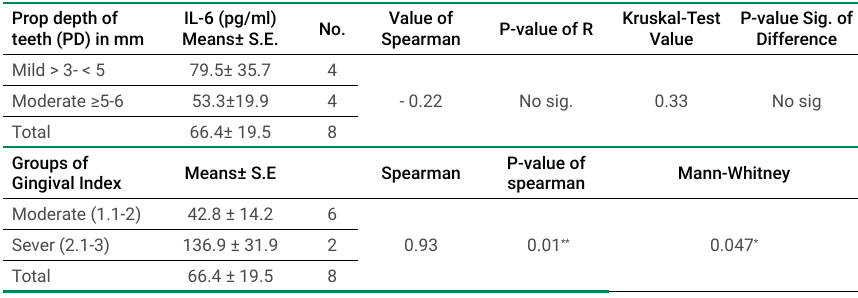
Table 4. Association of IL-6 with probe pocket depth, and gingival scores Prop depth of teeth (PD) in mm